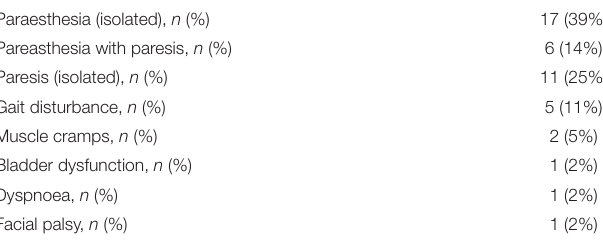
TABLE 2 | Initial symptoms of Sjögren’s